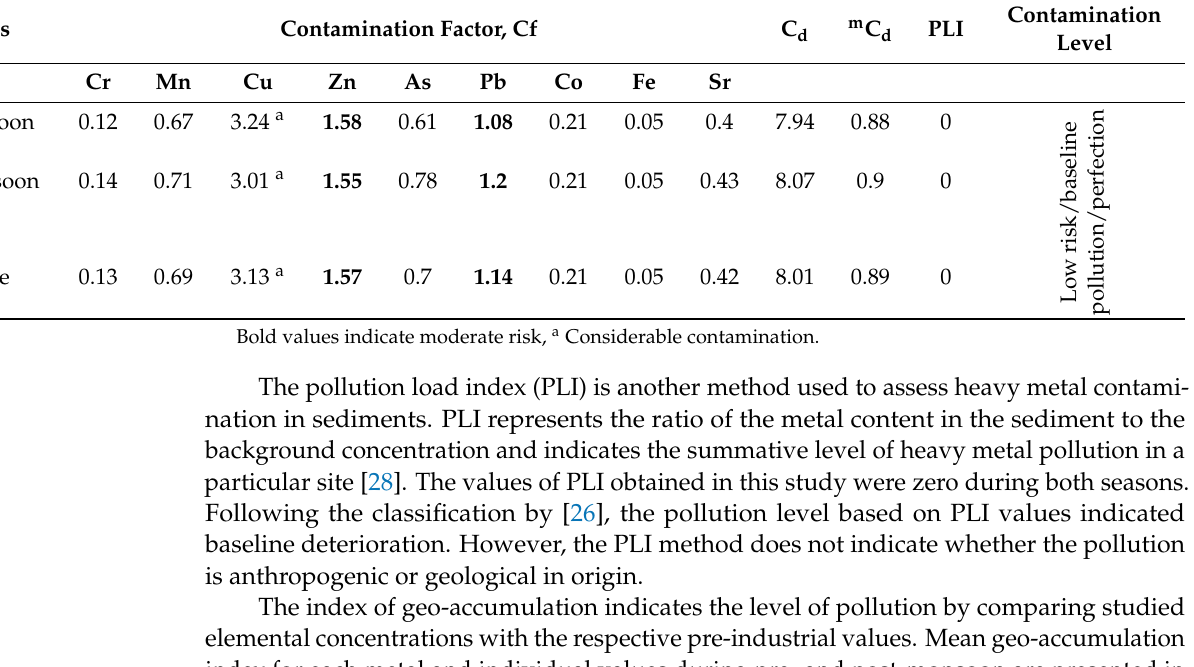
Table 5. Geo-accumulation index (Igeo) and Enrichment factor (EF) value for heavy metals concentration in soil from Kutubdia Channel, Bangladesh.